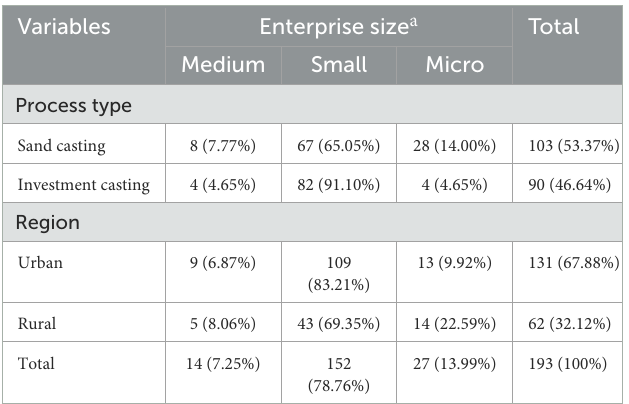
TABLE 2 Basic information of ferrous casting foundries in